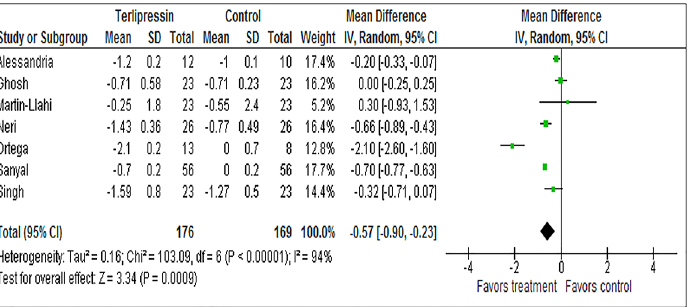
Fig 6. Change in Serum Creatinine in Survivors at the End of Treatment. Forrest plot assessing the weighted mean difference between delta creatinine in patients who survived treatment between those treated with terlipressin plus albumin vs all other control